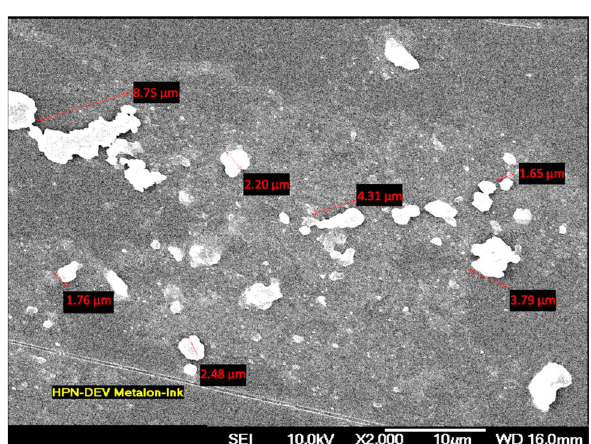
Figure 3. FE-SEM images of Ni flake particles at 2000 ×